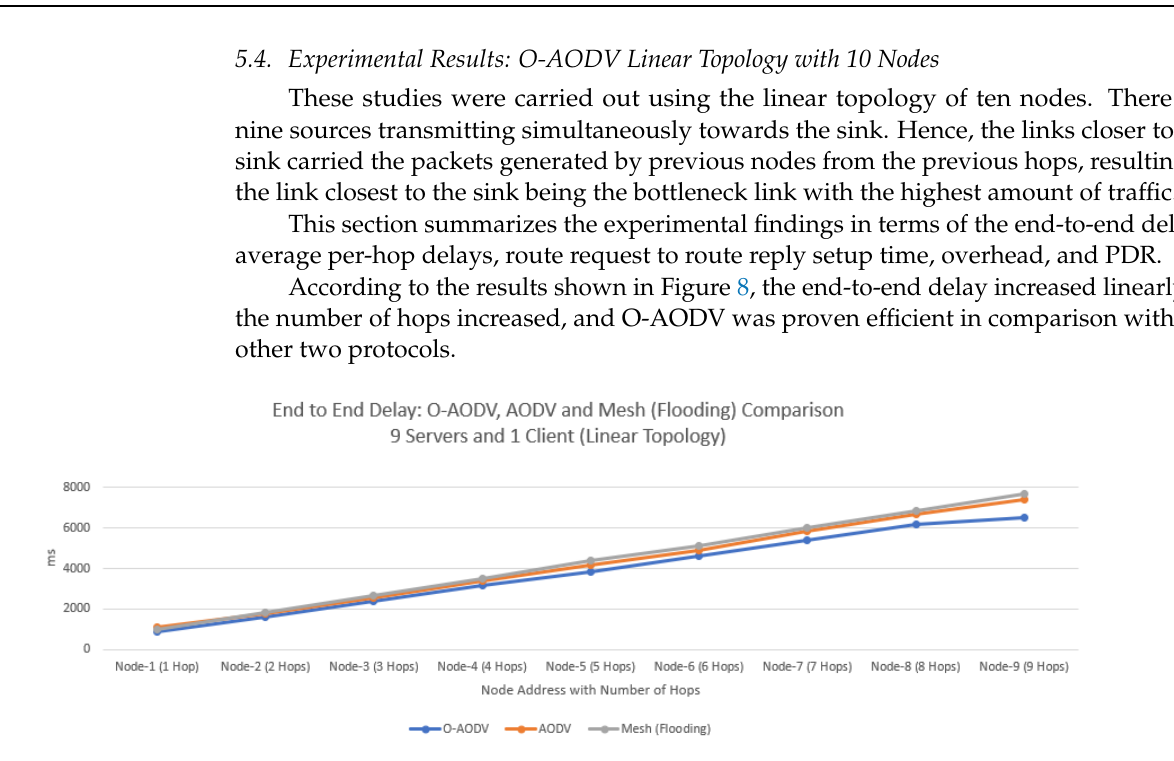
Figure 8. End-to-end, one-way delay: O-AODV, AODV, and mesh (flooding)